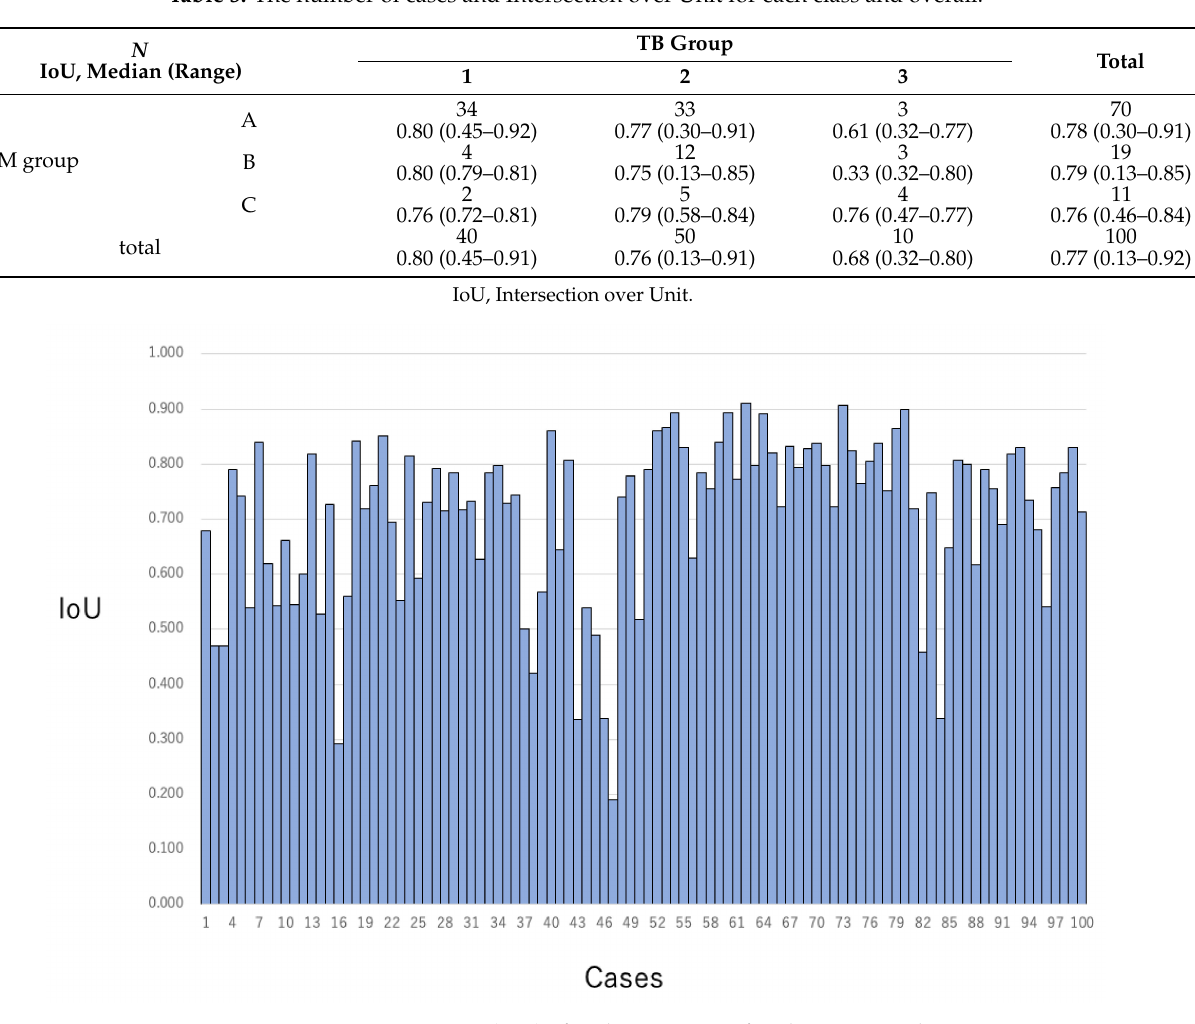
Figure 4. Intersection over Unit (IoU) of each case. IoUs of each case were